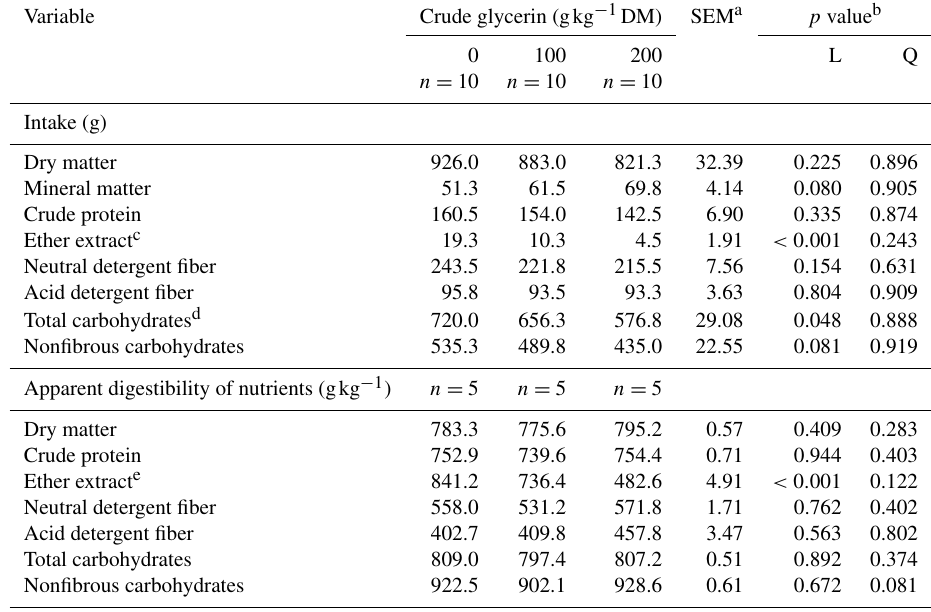
Table 3. Intake and digestibility of nutrients of feedlot lambs fed diets containing crude glycerin. Variable